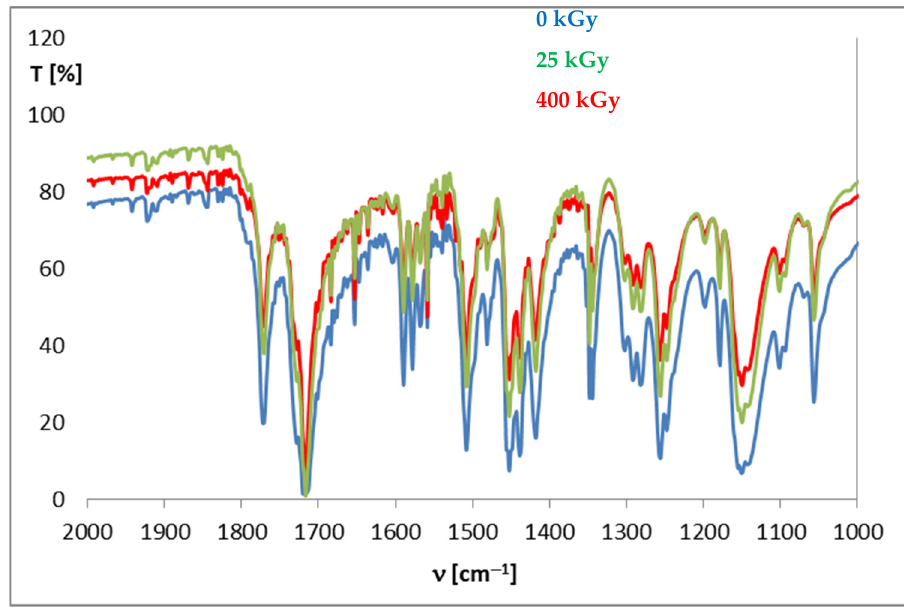
Figure 6. FT-IR spectra for aceclofenac before and after irradiation. Table 4. Purity factor for DC and AC in FT-IR method.